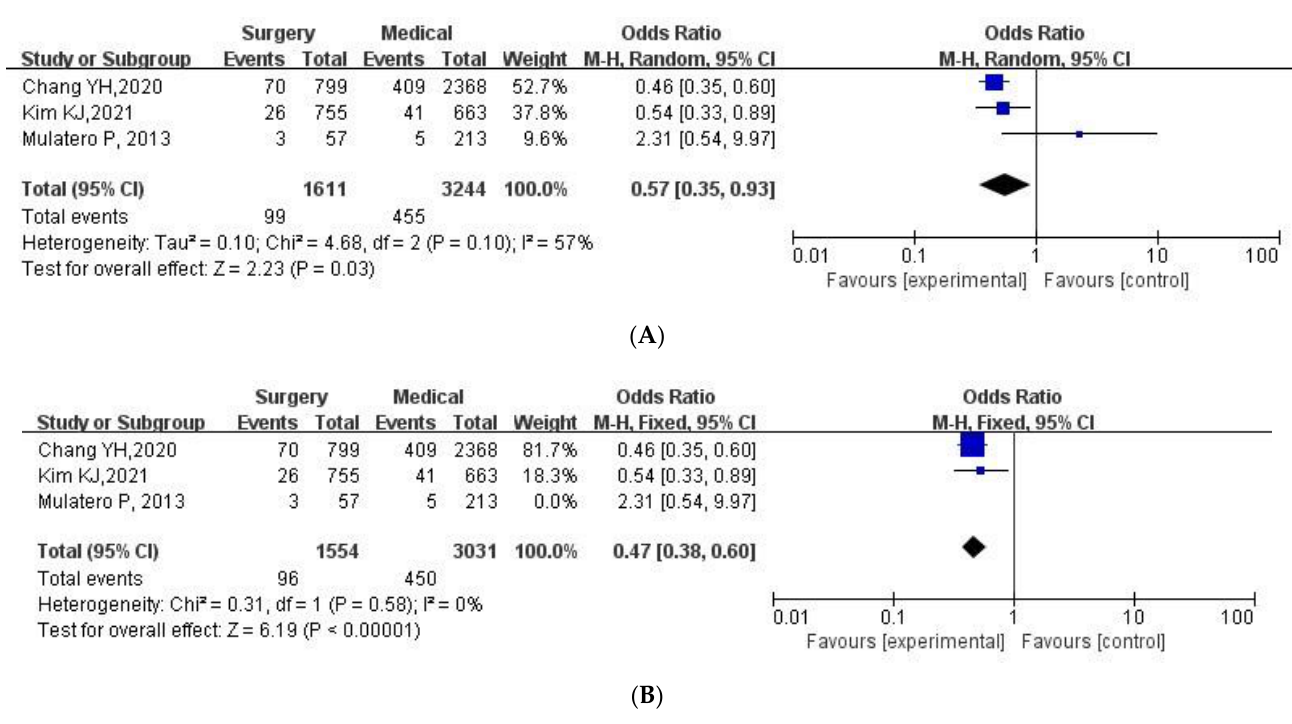
Figure 2. Forest plots of stroke in PA patients receiving surgical adrenalectomy treatment vs. med- ical treatment. PA, primary aldosteronism. Forest plots for the random effects model ( A ) and fixed effects model ( B ). The blue squares represent the results of individual studies and the black dia- monds represent the combined results of total studies in the model.